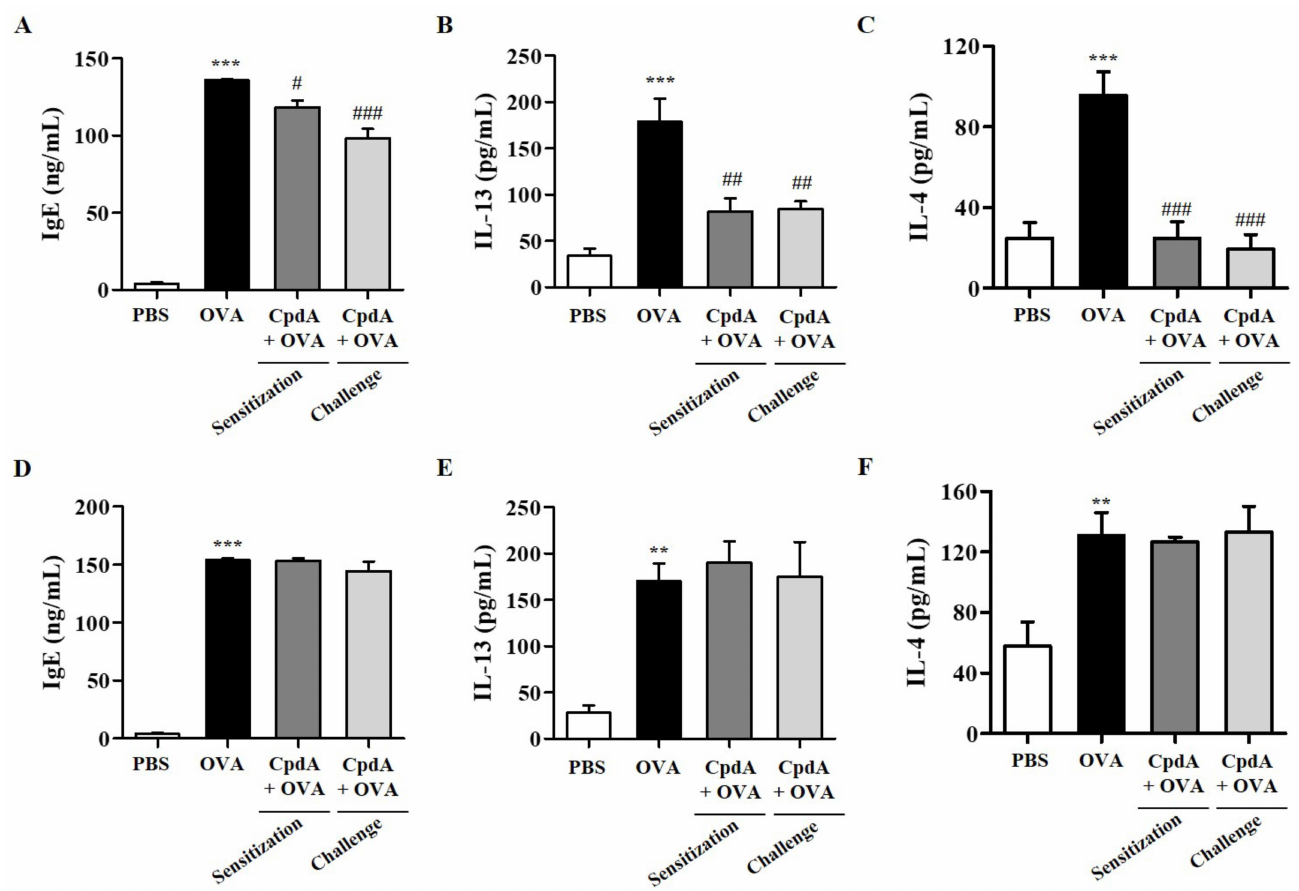
Figure 10. Effect of compound A on IgE levels in serum and levels of IL-13 and IL-4 cytokines in BALF. Serum IgE levels in FFA4-WT mice ( A ) and FFA4-KO mice ( D ). The results are presented as mean ± SEM ( n = 5). *** p < 0.001 vs. the PBS-treated group, # p < 0.05, ### p < 0.001 vs. the OVA-treated group. ELISA was used to measure the protein levels of IL-13 and IL-4 in BALF from FFA4-WT mice ( B , C ) and FFA4-KO mice ( E , F ). The results represent the mean ± SEM of protein levels ( n = 5). ** p < 0.01, *** p < 0.001 vs. the PBS-treated group. ## p < 0.01, ### p < 0.001 vs.